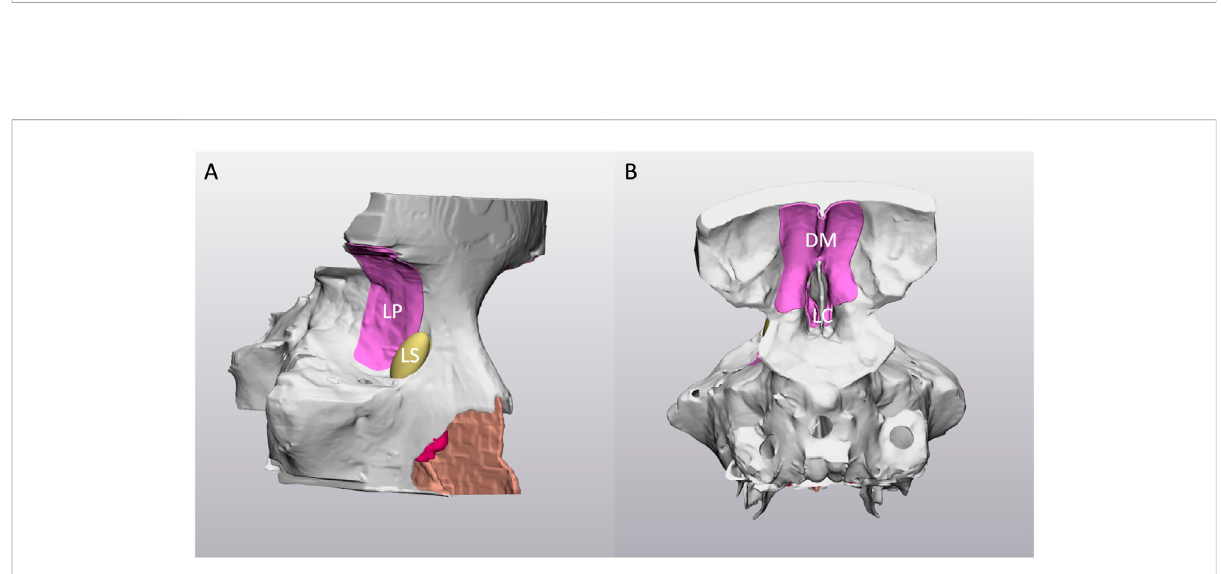
FIGURE 2 Right-lateral (A) and posterior (B) view of the virtual 3D model. Note the holes on the sphenoid sinus to allow the cleaning after the 3D printing process. LP : lamina papyracea; LS : nasolacrimal sac; DM : dura mater; LC : lamina